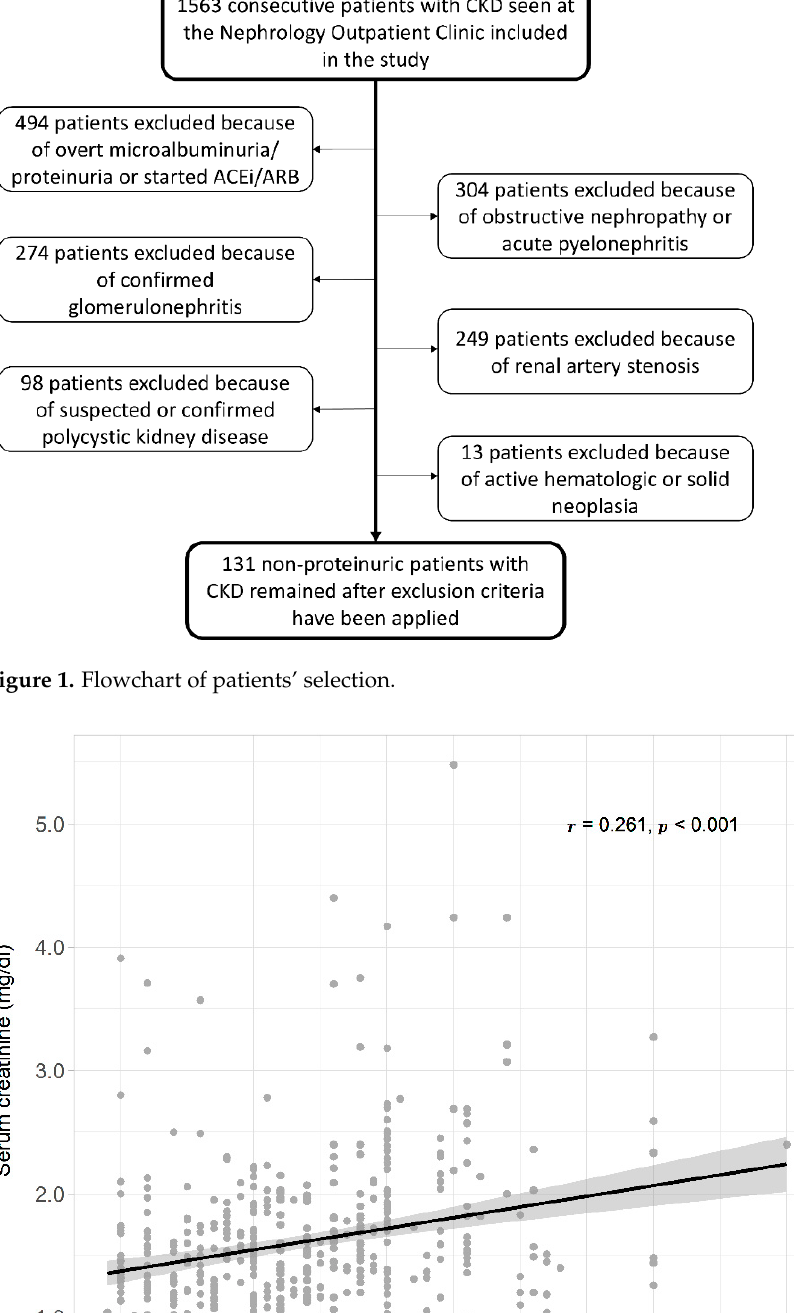
Table 1. Baseline correlation analysis and best model of determinants of GFR and intrarenal resistive index.